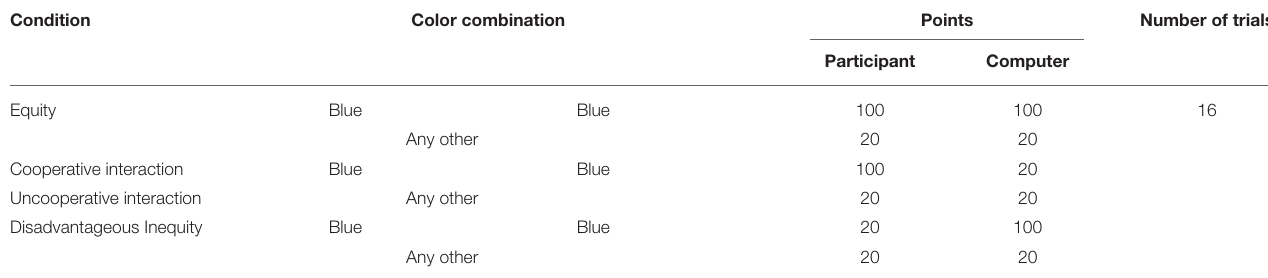
TABLE 1 | Points received by the participant and the computer with each card color combination and the number of trials in each condition.